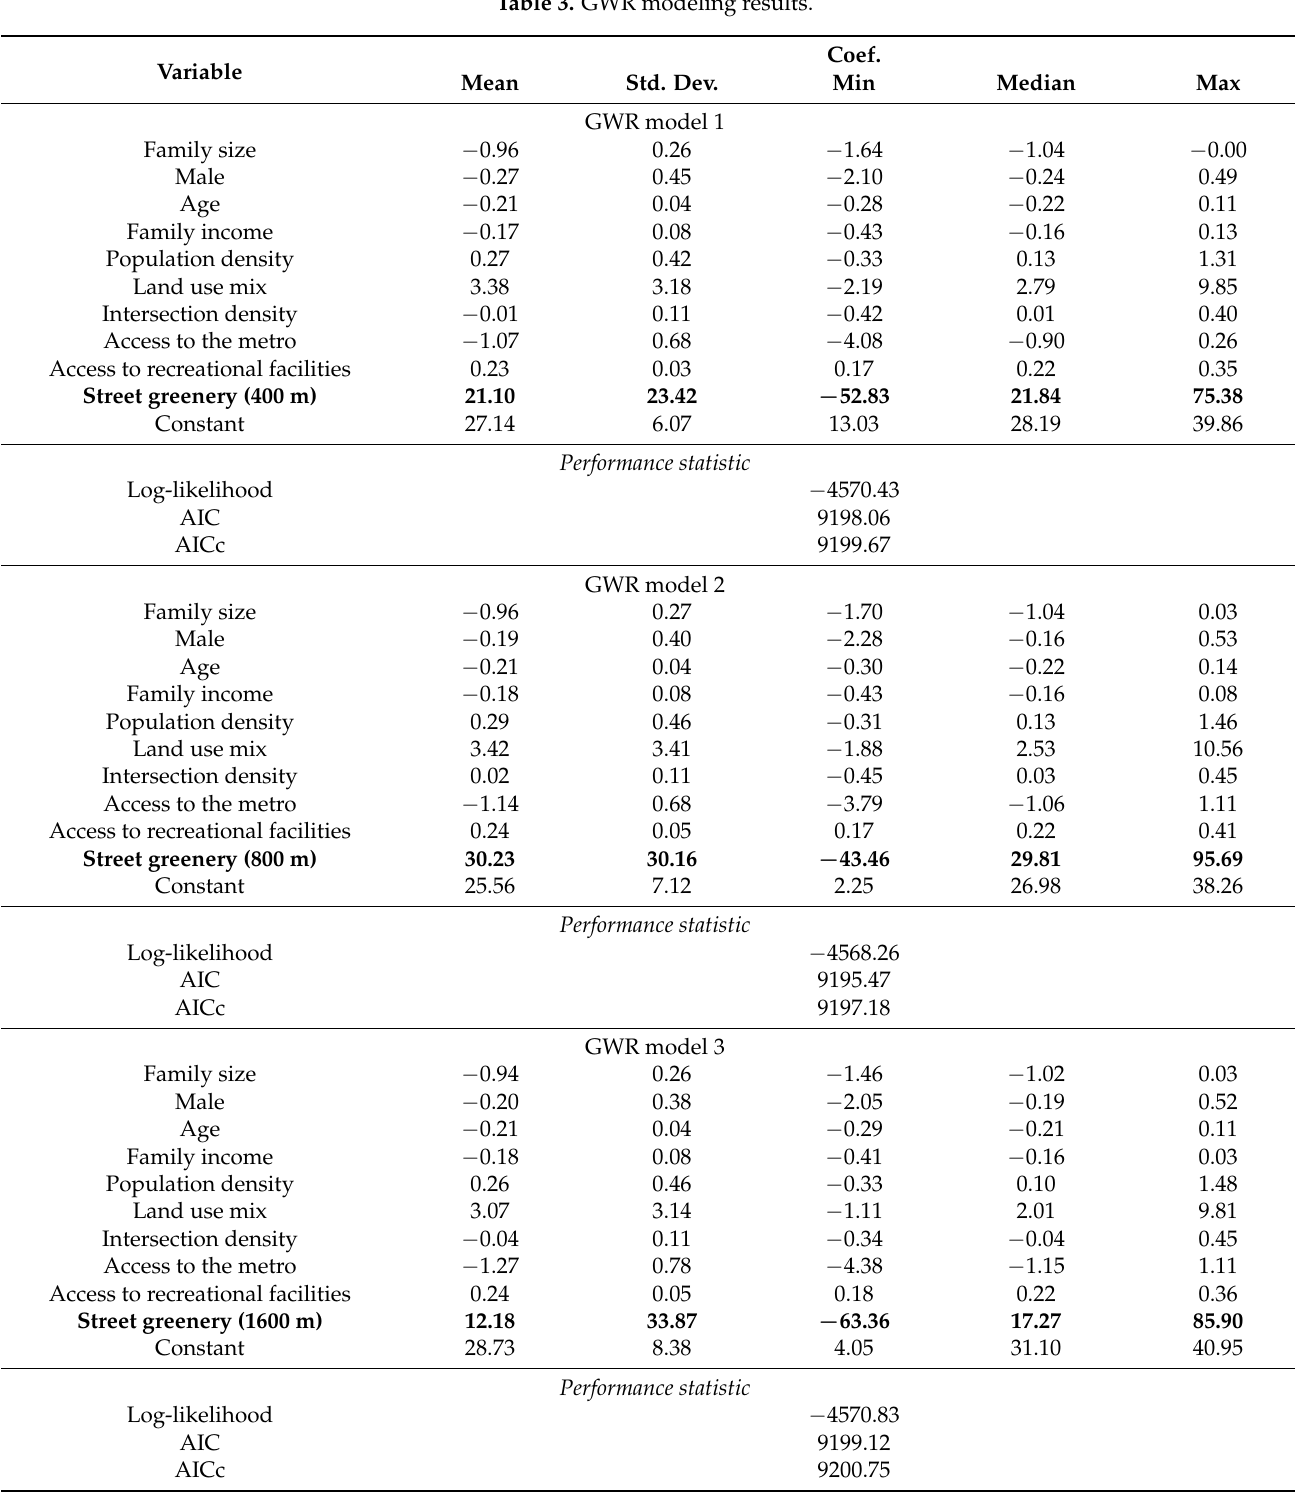
Table 3. GWR modeling